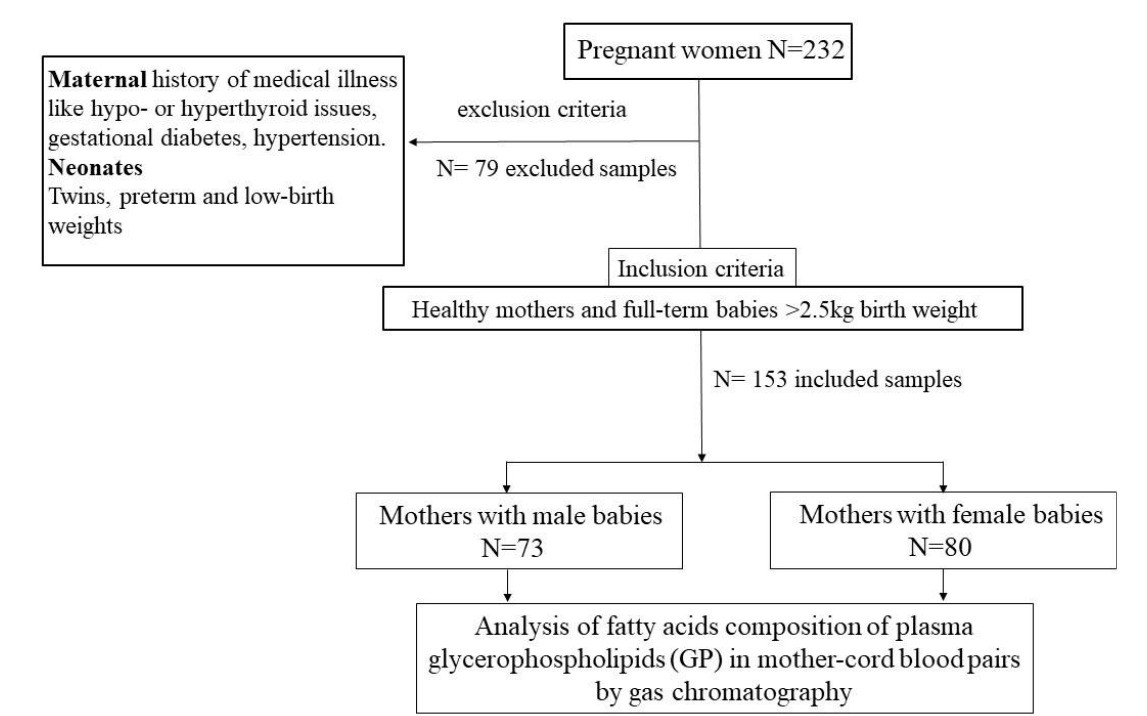
Figure 1 outlines the design of a human cross-sectional study. The following criteria were considered for the random selection of samples for the study.